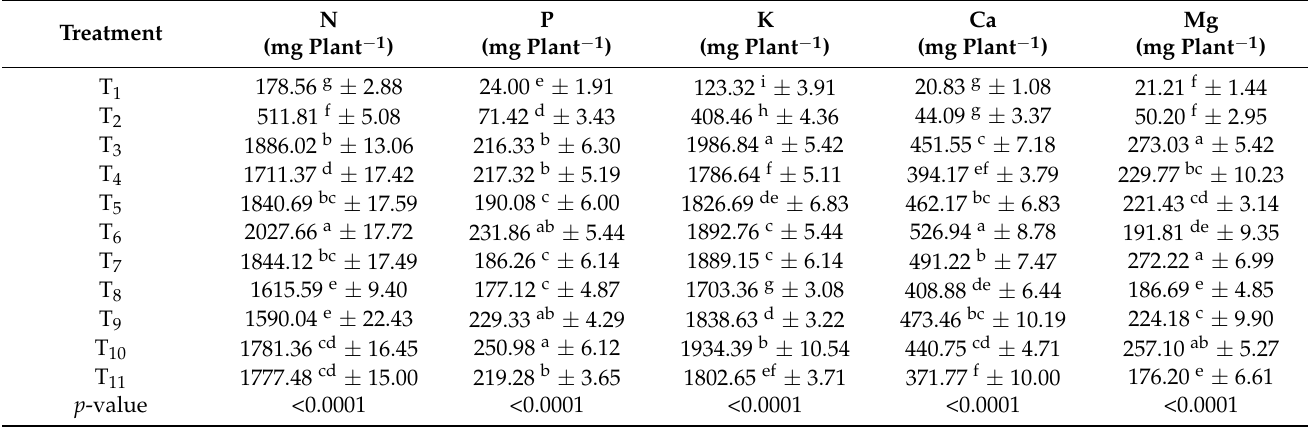
Table 8. Effect of treatments on changes in plant nutrient